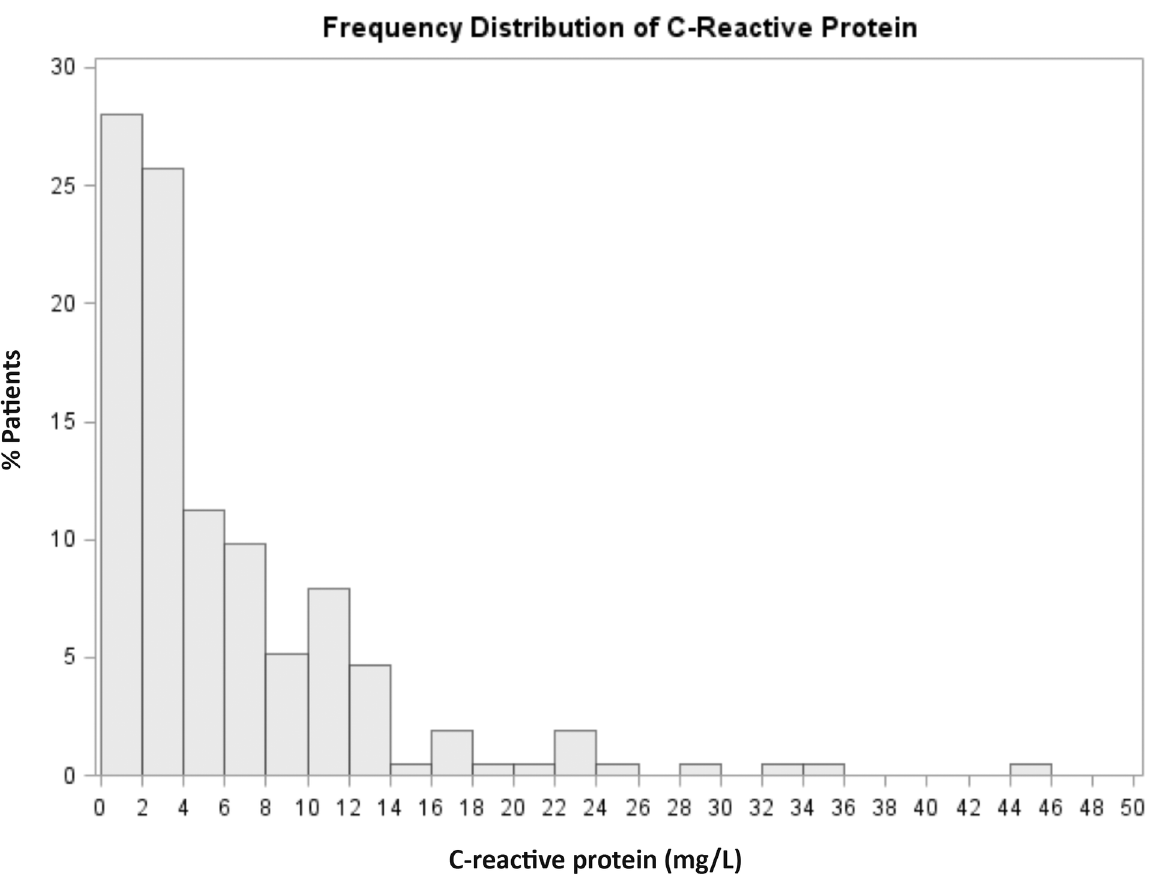
Fig 1. Frequency distribution of high-sensitivity C-reactive protein (CRP) levels in heart failure with preserved ejection fraction. Overall, median CRP levels were 3.69mg/L (interquartile range 1.83–8.12 mg/L with a range of 0.16 to 44.0 mg/L).